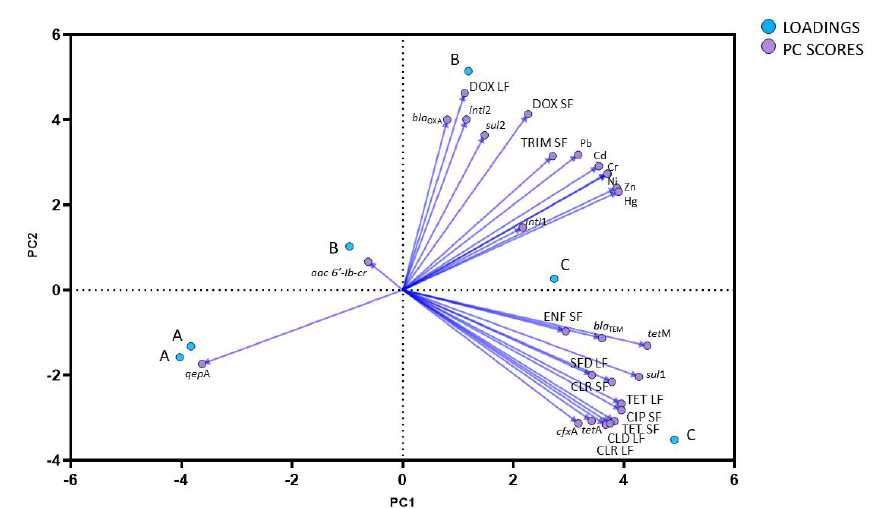
Figure 3. Principal Component Analysis (PCA) based on the distribution of ARGs and integrase genes, pharmaceuticals, and heavy metals (HMs) in all investigated samples. Mean loadings for ARGs and the content of antibiotics and HMs, and mean PC scores for biogas plants: A — biogas plant 1 (BP1), B — biogas plant 2 (BP2) and C — biogas plant 3 (BP3).